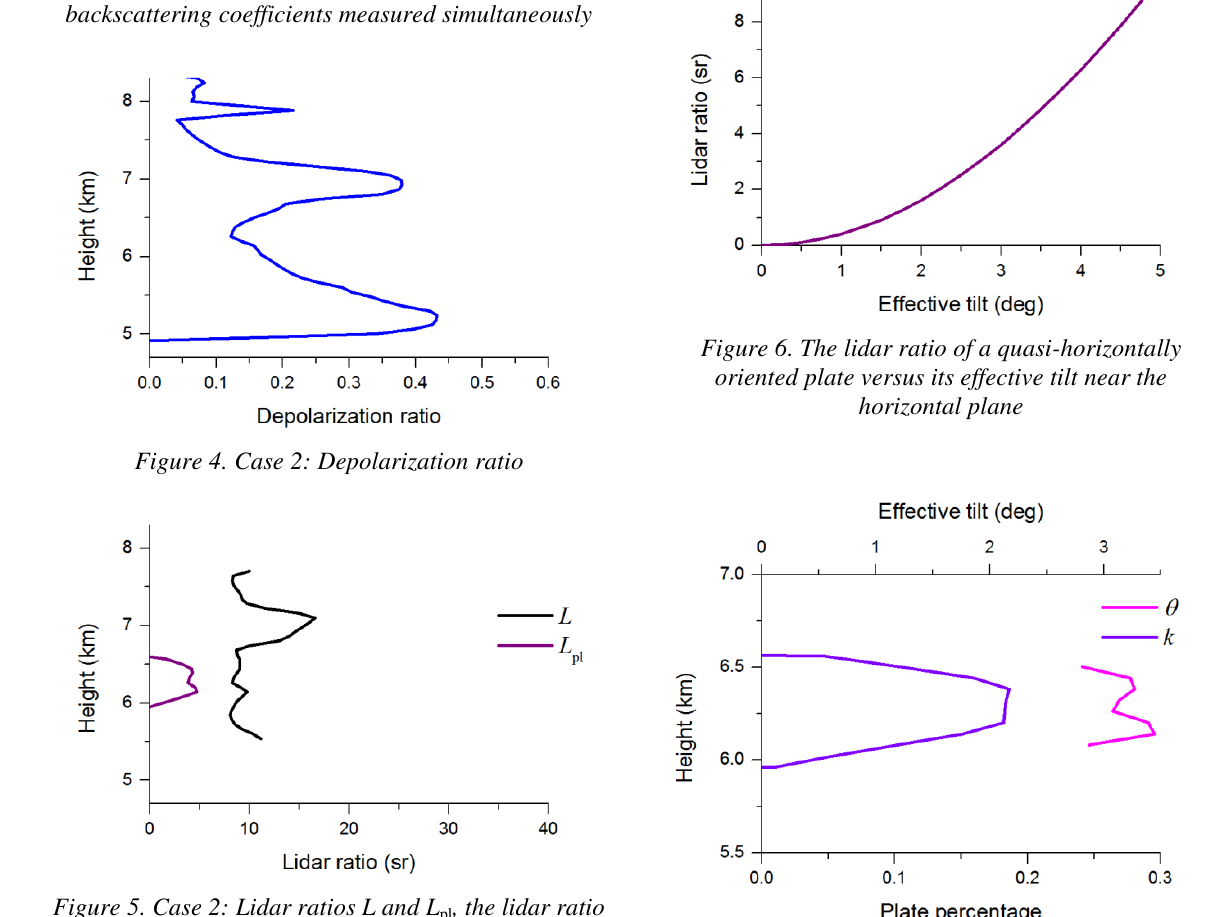
Figure 5. Case 2: Lidar ratios L and L of the horizontally oriented plates [see defining Eq.